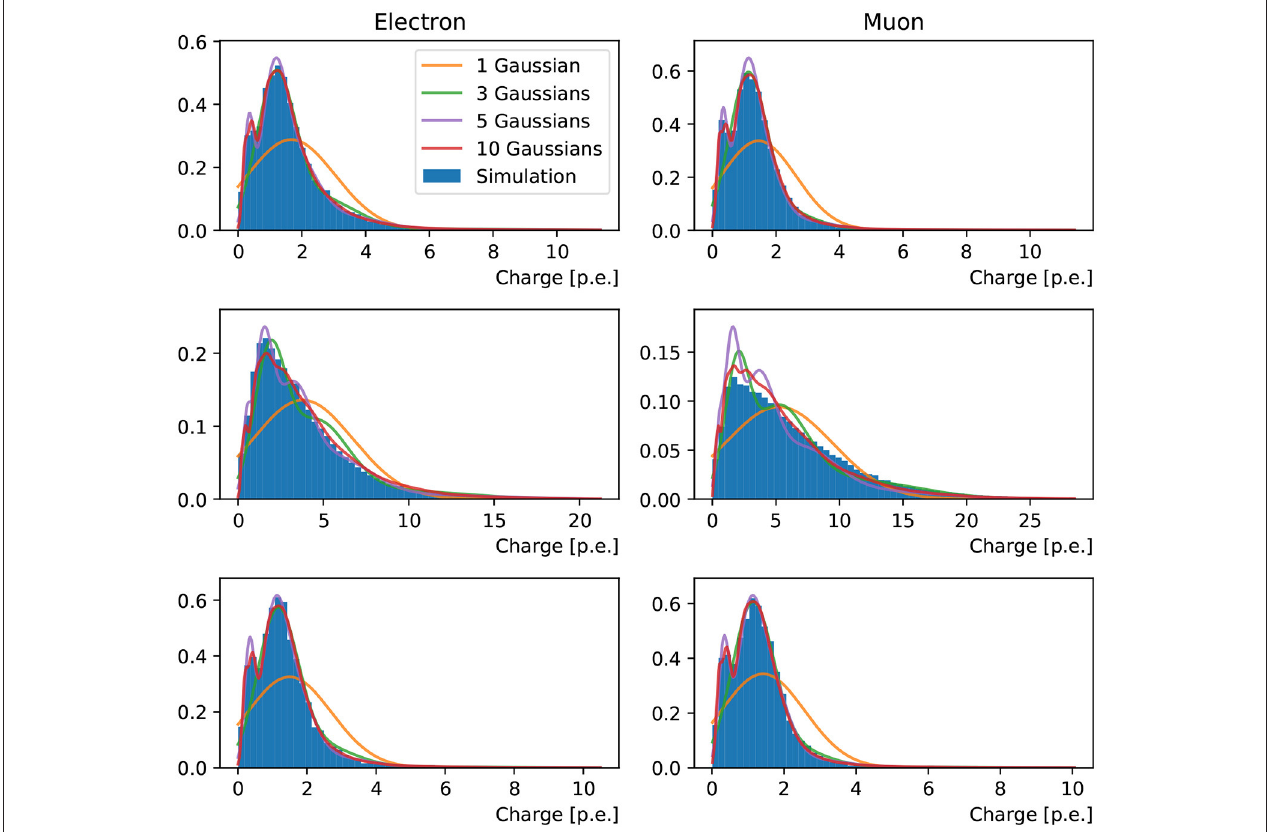
FIGURE 5 | Distributions of hit charges for electrons (left) and muons (right) events in the three reference PMTs: in the center (top) , edge (middle) and, outside (bottom) of the Cherenkov ring pattern produced by events generated with fixed kinematics. Predictions of the neural network trained with 1, 3, 5, and 10 Gaussian components are superimposed on the